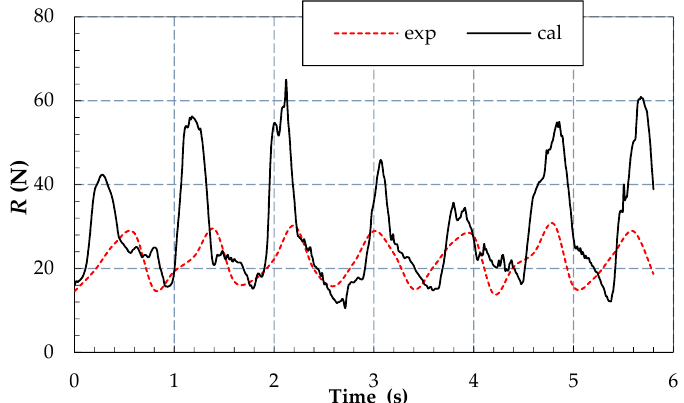
Figure 21. Cycle oscillation resistance contrast curves for the operation condition of λ = 7 m, F n = 0.99.